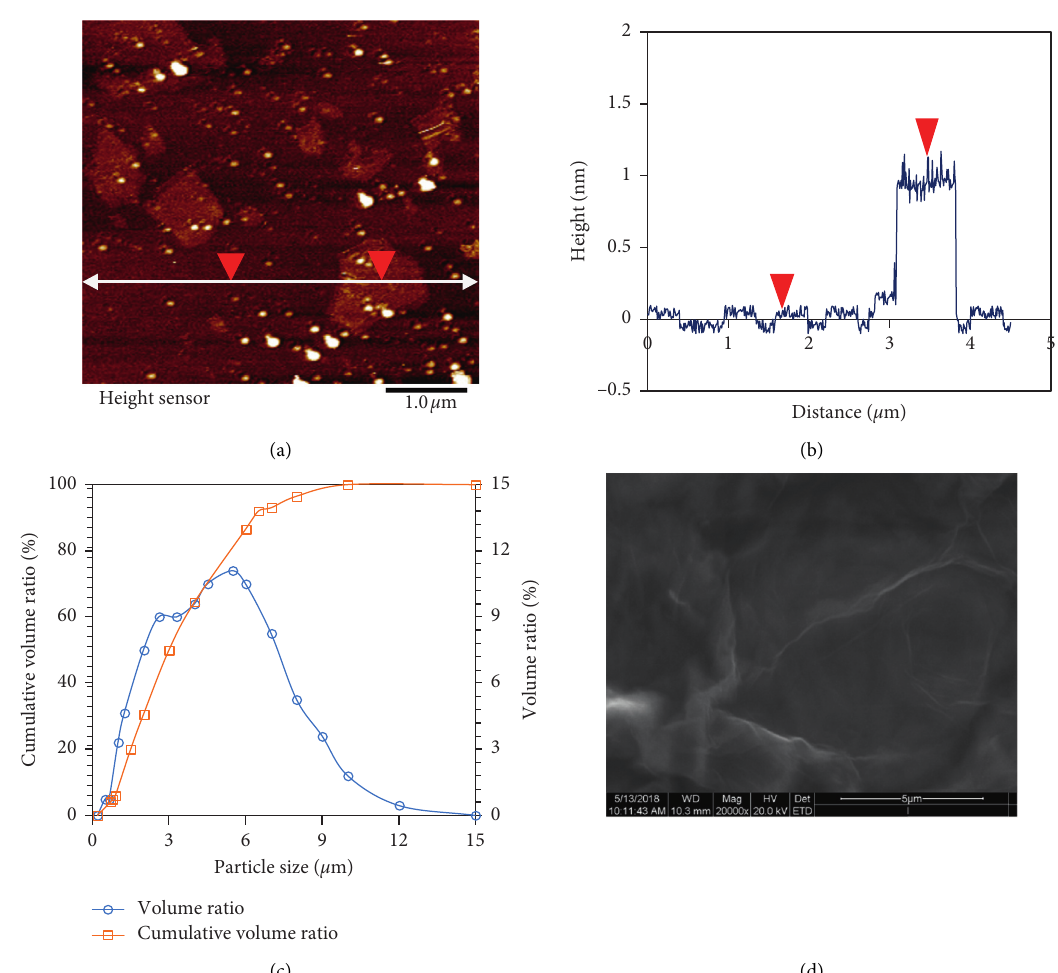
Figure 5: Characterization of GO: (a) AFM image of GO; (b) height profile of GO nanosheet; (c) size distribution curves of GO; (d) SEM image of